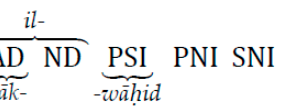
Figure 6. Reference Hierarchy for western Hassaniya varieties.